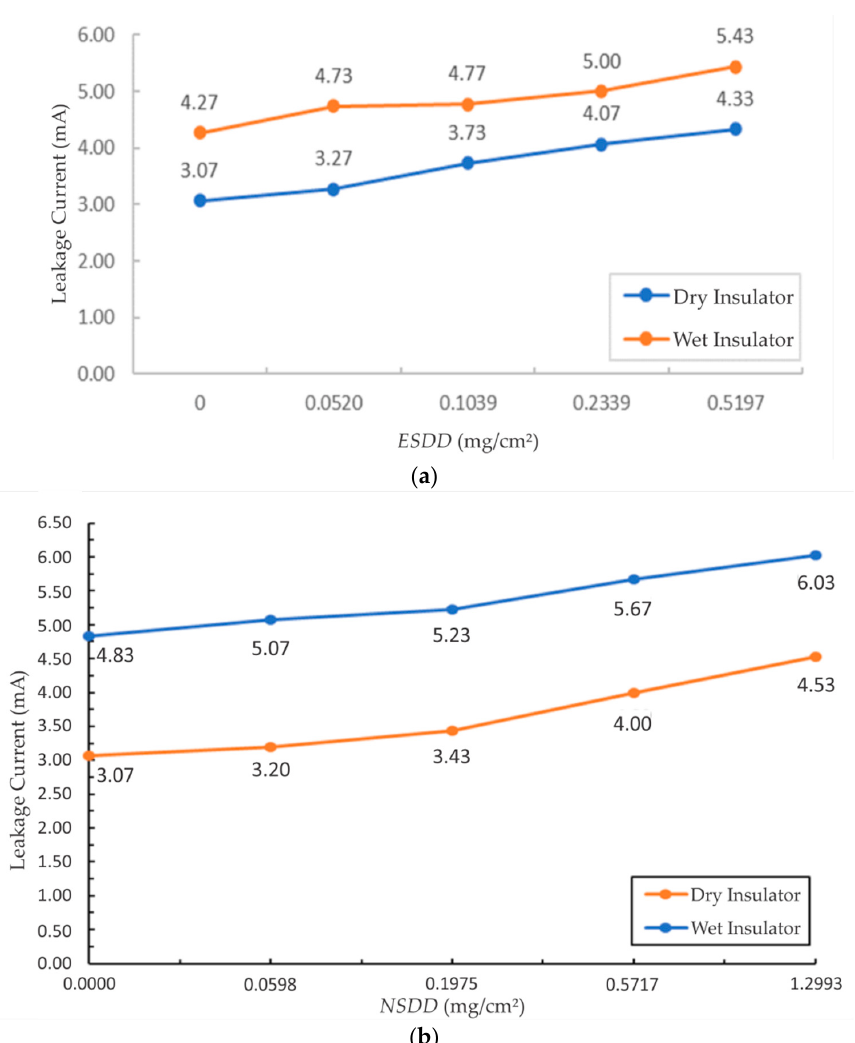
Figure 18. Comparison of dry insulator leakage current with wet insulator ( a ) salt contaminants and ( b ) fly ash contaminants.